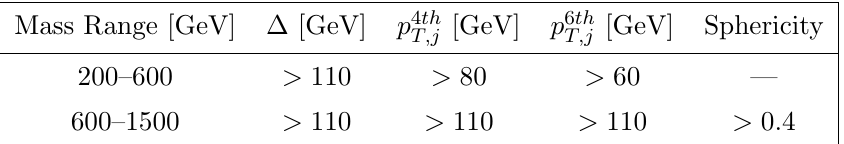
Table 4. The selection criteria with the direction of the cut for the CMS heavy (cid:13)avour search p performed at s = 8 TeV